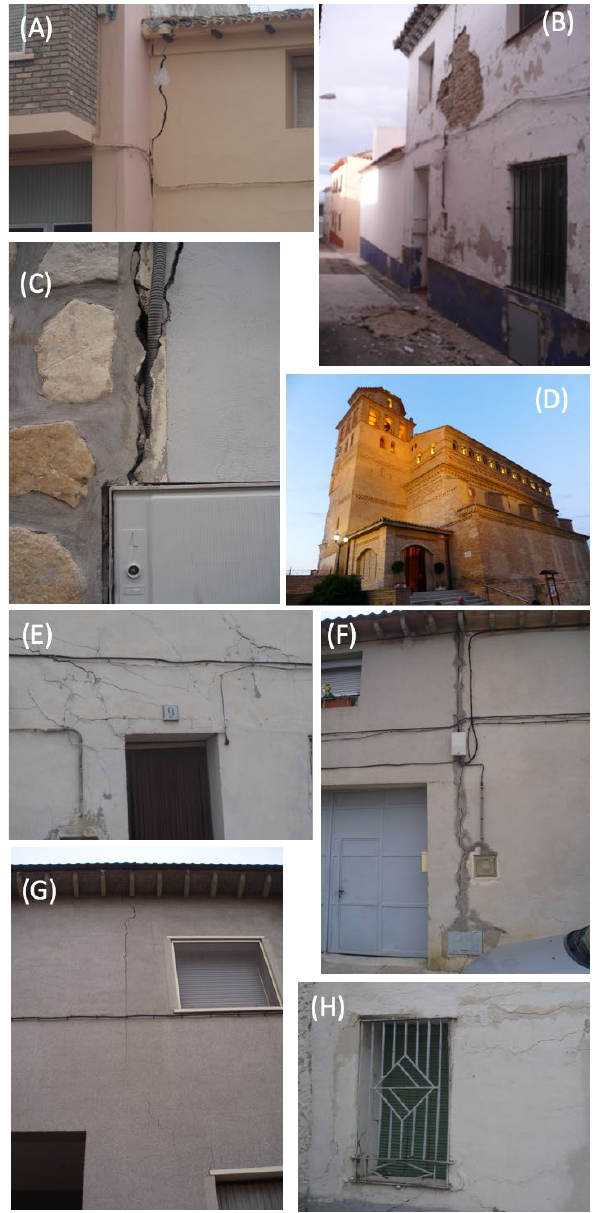
Figure 9. View of pathologies outside several Perdiguera